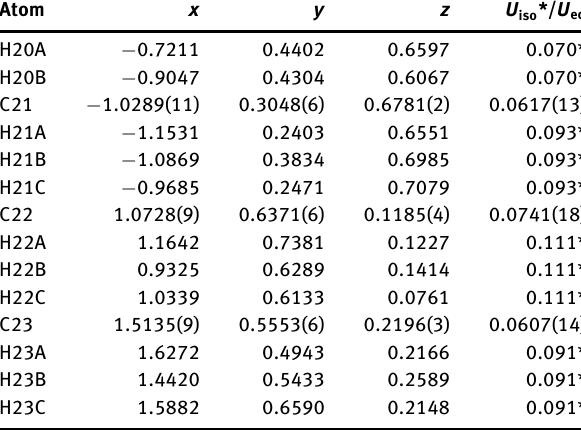
The H atoms were geometrically placed (C—H = 0.95–0.99 Å) and refined as riding with U